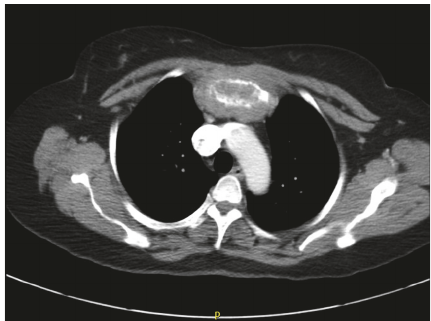
Figure 2: 2.1 × 1.5 cm soft tissue infiltrating along the manubrium with underlying destruction of the bone.